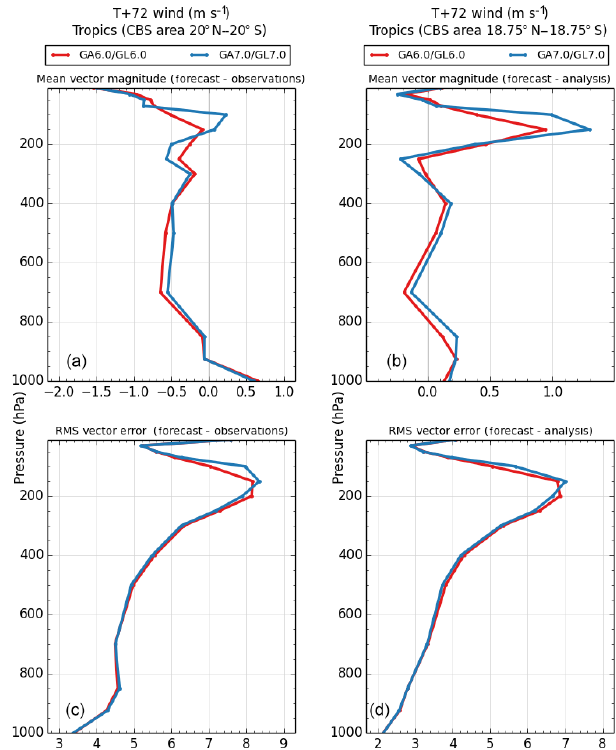
Figure 22. Profiles of 3-day (T + 72) tropical temperature bias (a, b) and RMSE (c, d) versus radiosonde observations (a, c) and ECMWF analyses (b, d) from the N768 GA6.0 and GA7.0 case studies presented in Fig. 21.